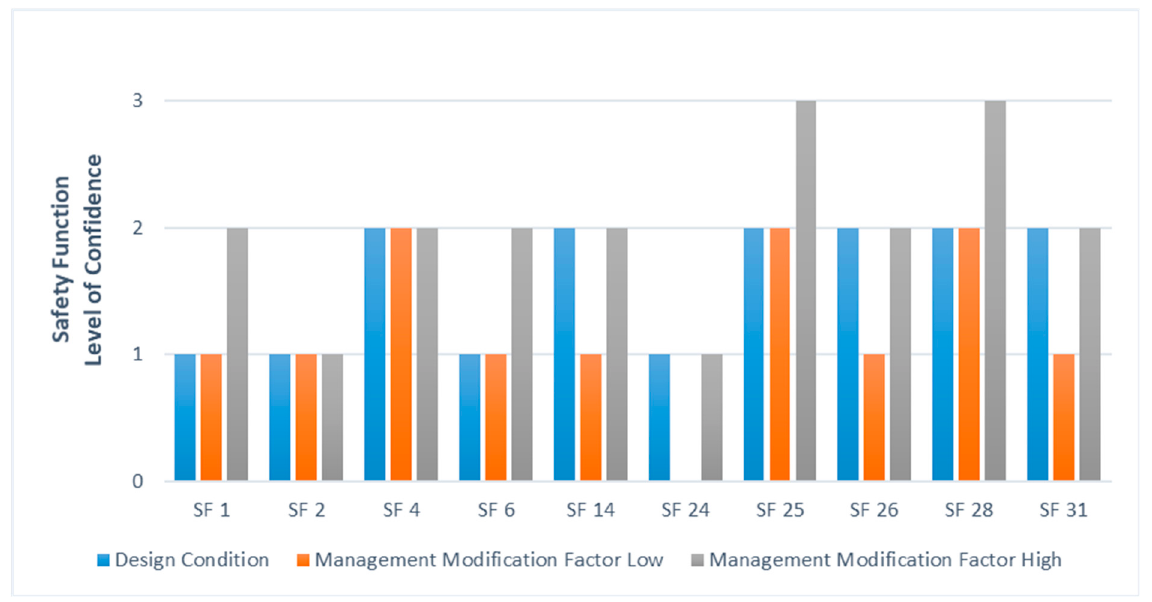
Figure 8. Level of Confidence of Safety Functions: comparison for the different management performance conditions.